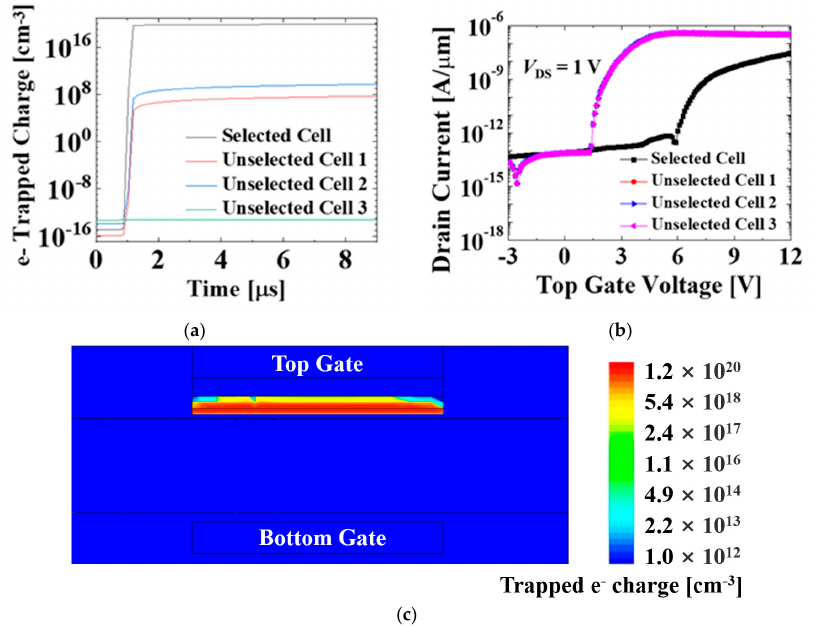
Figure 5. ( a ) Change of electron charge trap density during programming at the cells of the proposed NOR array design. The density of trapped electron charge becomes saturated due to limited top gate voltage. In the selected cell, the higher top gate voltage may increase the saturated density of the trapped electron charge; ( b ) transfer characteristics just after programming of the cells in the proposed NOR array design; ( c ) cross-sectional view of the selected cell with TAHOS structure that illustrates the distribution of the trapped electron charge after